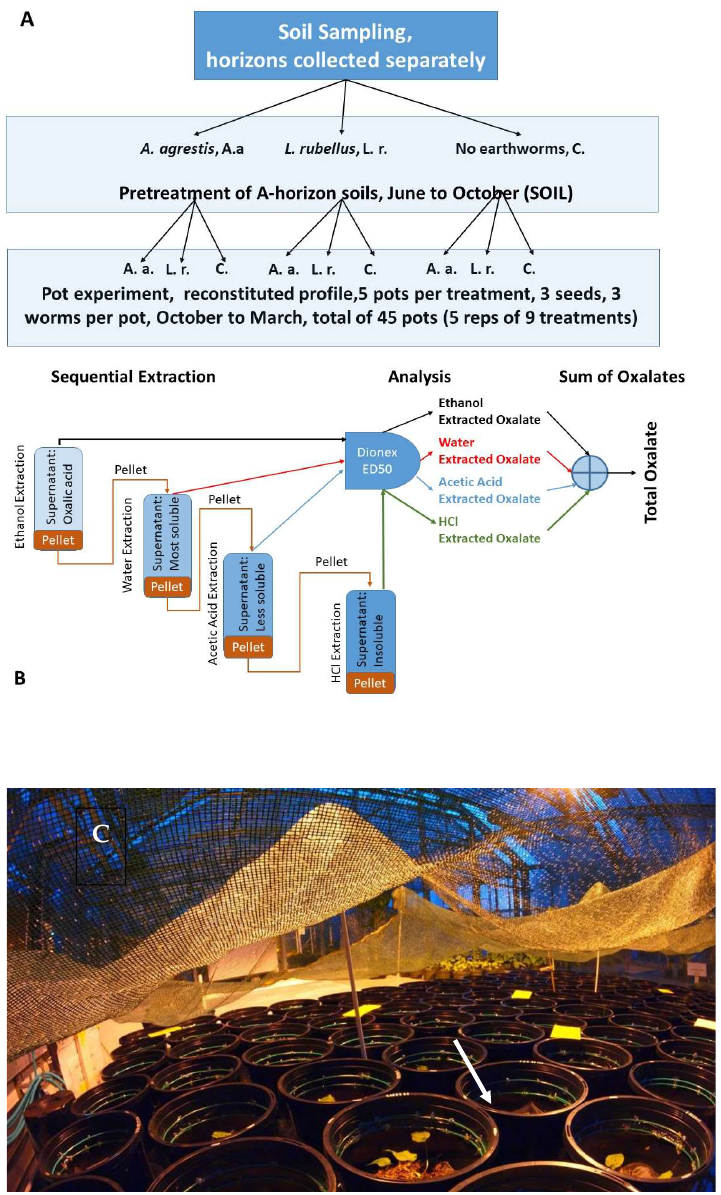
Figure 3. ( A ) Experimental design showing the relationship between soil pretreatments (SOIL) and pot treatments (WORM). A.a.—Amynthas agrestis, L.r.—Lumbricus rubellus, C.—no earthworms added (control). ( B ) Sequential extraction of oxalate fractions, with solid fraction (pellet) from earlier extraction passed to next extraction. Total oxalates represents the sum of all solubility fractions. ( C ) Experimental setting in greenhouse showing shade cloth and pots with hook-up wire (arrow) a month after the initiation of the experiment.